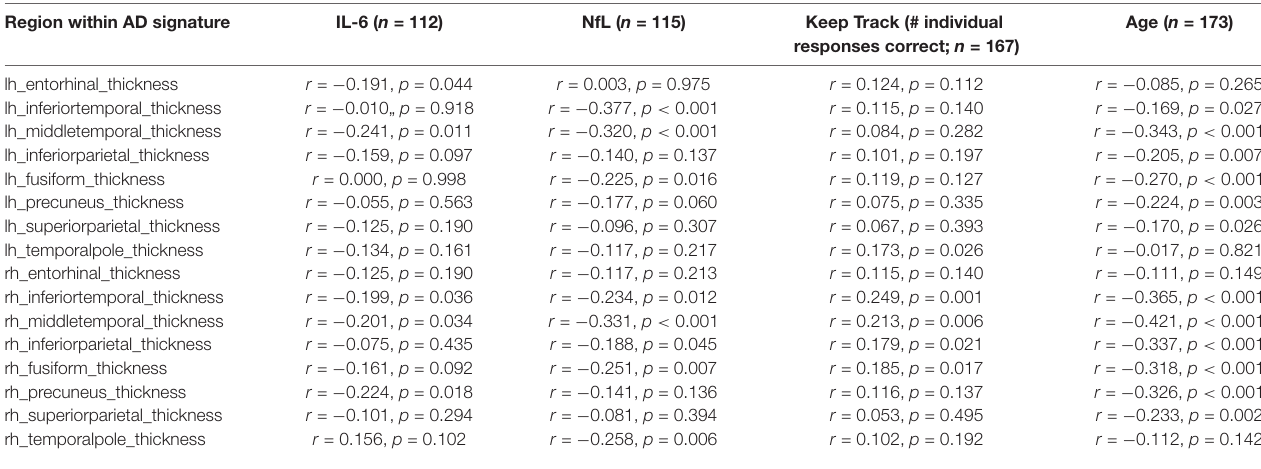
TABLE 2 | Correlations between individual regions within AD signature and variables of